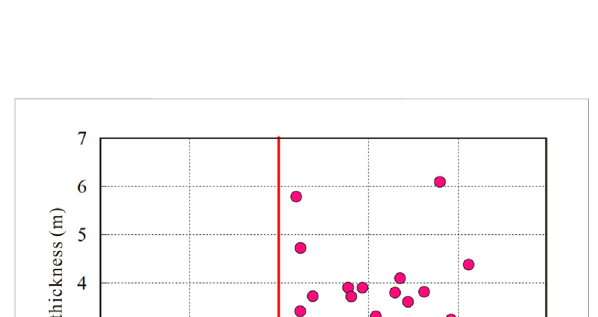
FIGURE 12 Schematic diagram of hydrocarbon migration in different structural units of the Yanchang Formation.